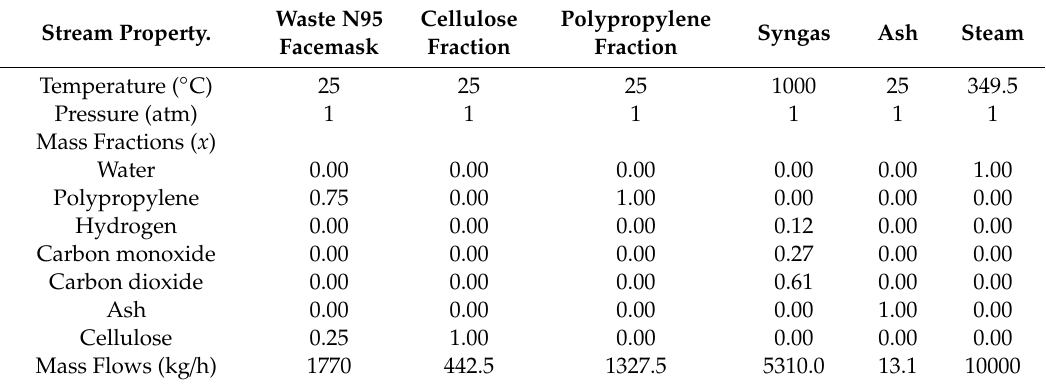
Table 3. Mass balance results for major streams in the process for waste N95 facemask gasification for steam and power generation (scenario